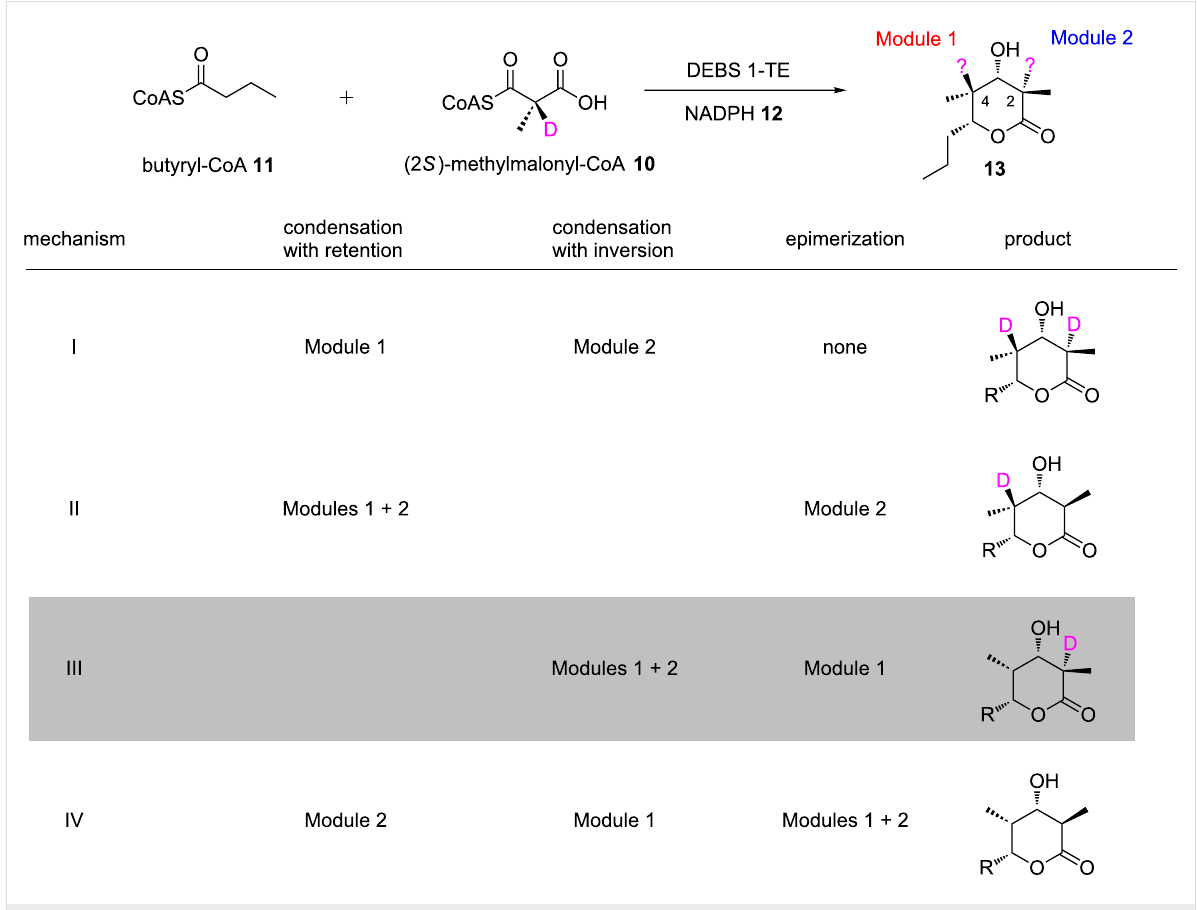
Figure 9: Experiment in vitro to determine the stereochemistry of condensation in modular PKS [46]. Use of specifically C-2-deuterium labeled extender unit 10 during biosynthesis with DEBS 1-TE (alongside starter unit butyryl-CoA 11 and NADPH 12 ), resulted in a labeling pattern in the trike- tide lactone product 13 , which allowed discrimination between the four possible mechanisms for condensation in modules 1 and 2 of the PKS (the C-2 methyl center of the product is established by module 2 and the C-4 center by module 1). The obtained pattern (exclusive deuterium labeling at the C-2 position) was consistent with mechanism III (boxed) – inversion of stereochemistry in both modules as found for fatty acid synthase, with an addi- tional epimerization occurring in module 1 to give the observed final